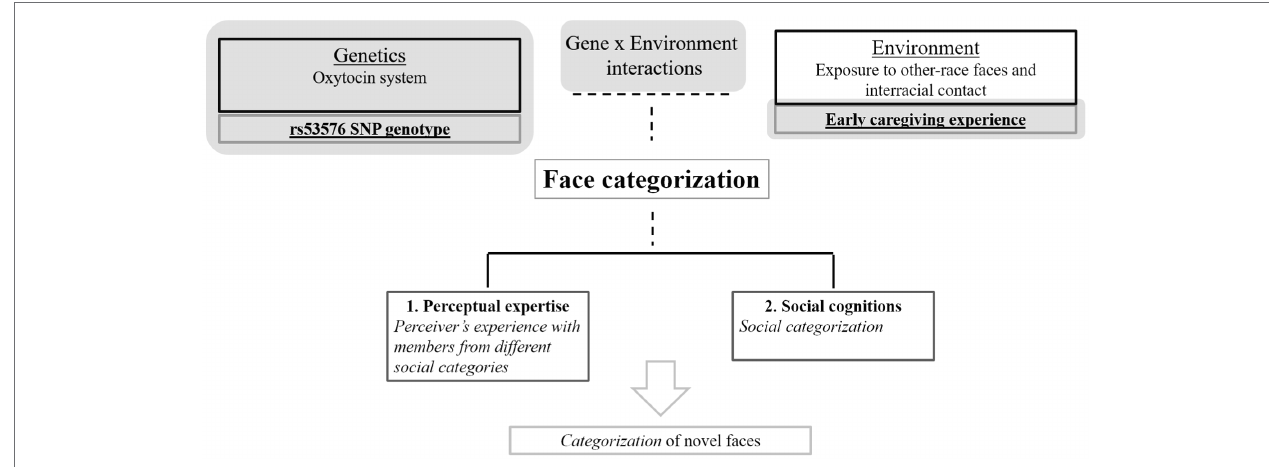
FIGURE 1 | Diagram of key research variables of the present study highlighted in grey in the